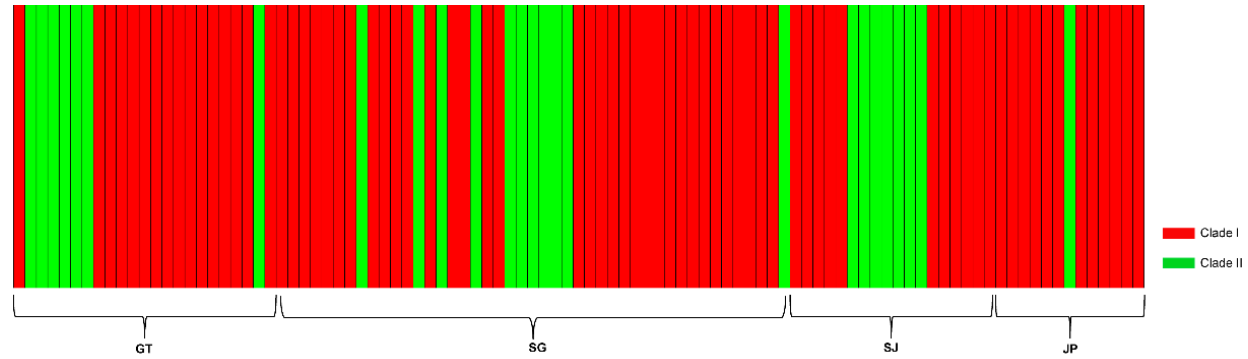
Figure 3. The haplotype network of Schizothorax kozlovi based on the concatenated sequences of gene Cyt b and COI.